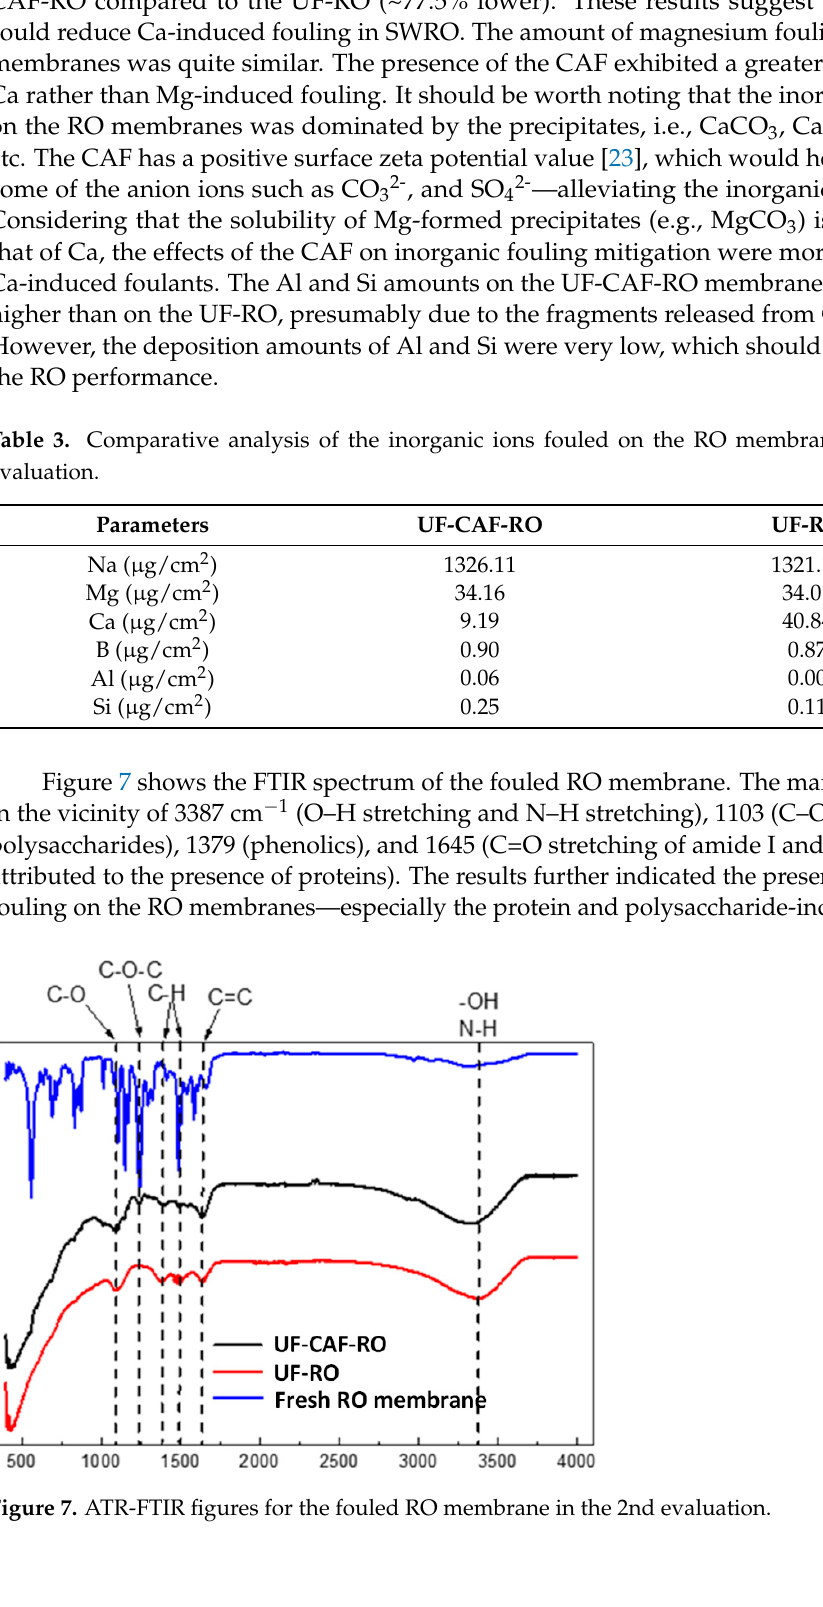
Figure 7. ATR-FTIR figures for the fouled RO membrane in the 2nd